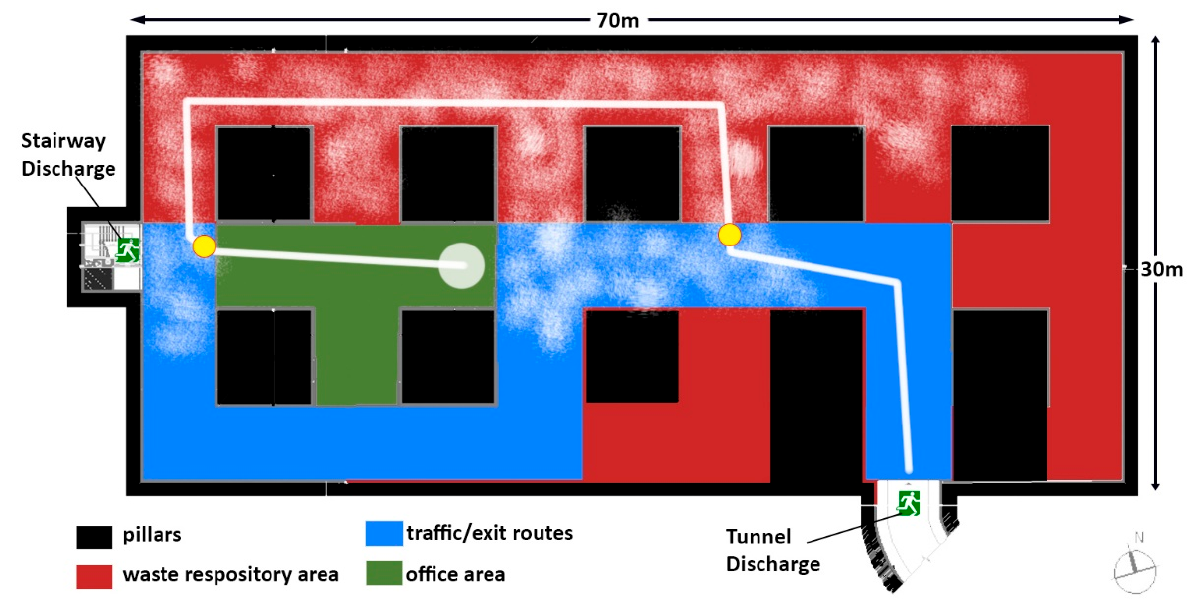
Figure 16. Smoke production machine.